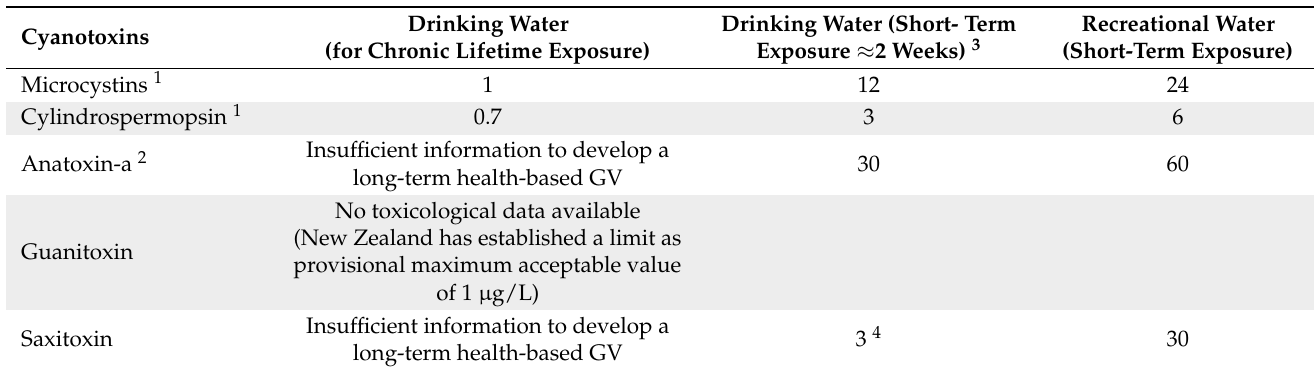
Table 2. Health-Based Guidance Values (HBGV) and other recommended values for various exposure scenarios ( µ